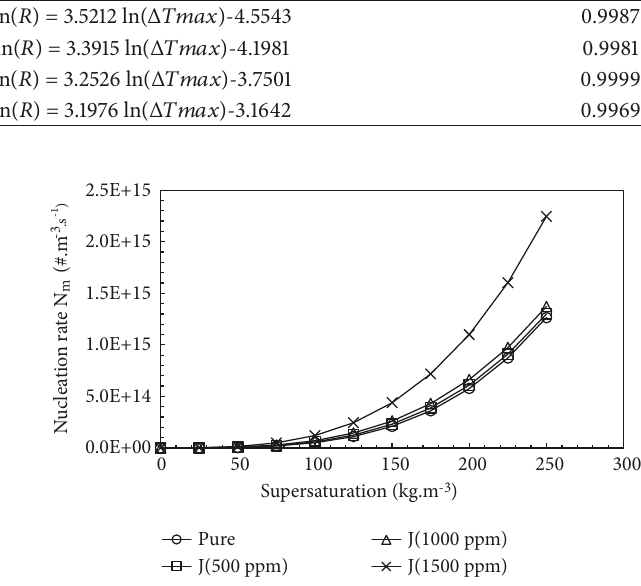
Figure 4: Nucleation rate as a function of supersaturation in aqueous solutions without and with